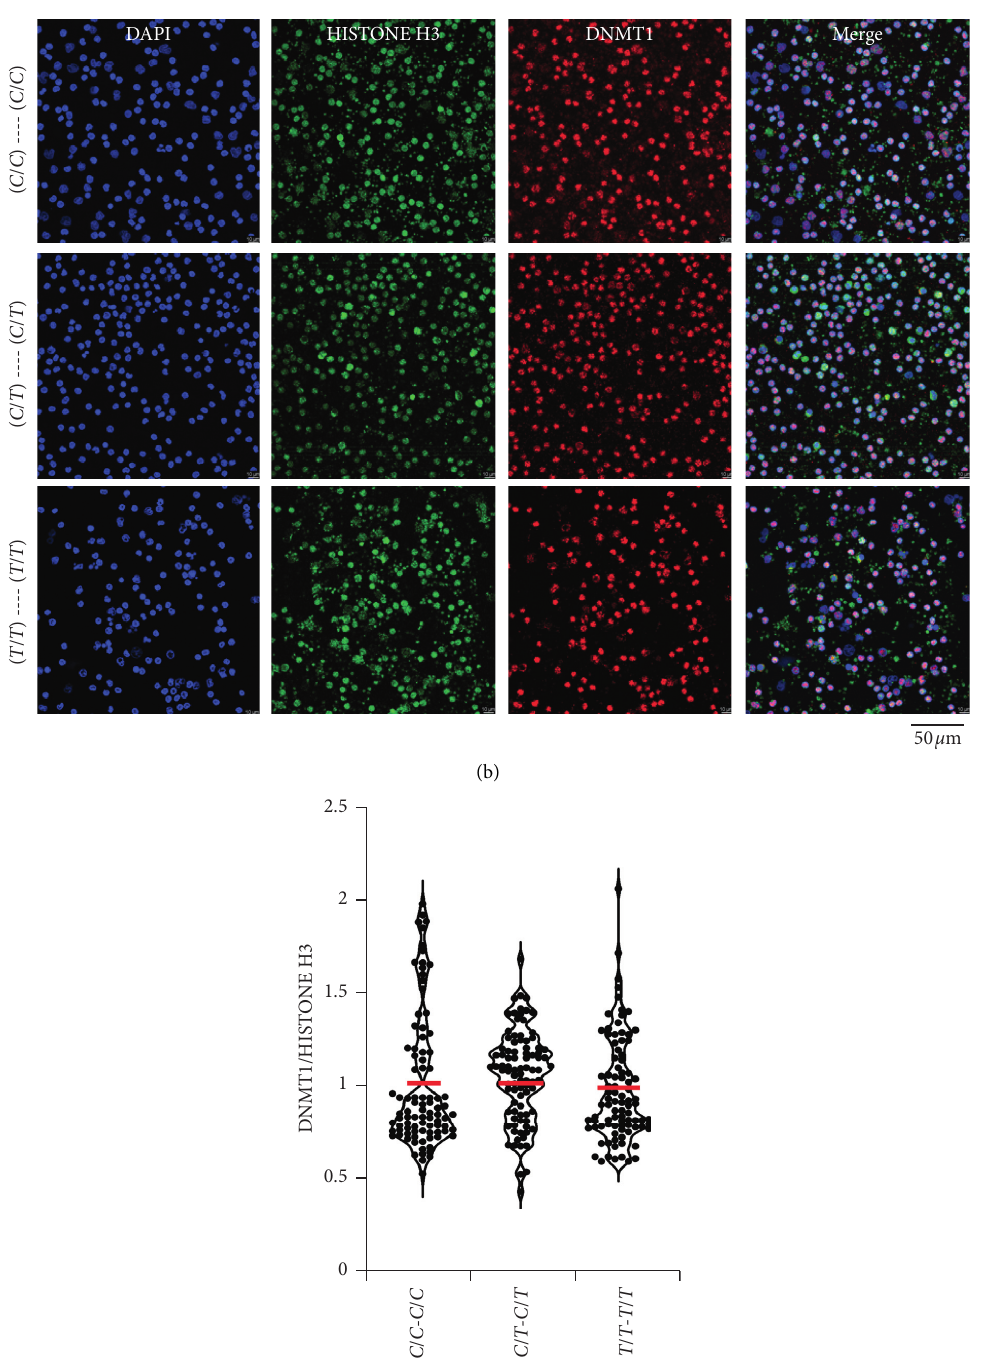
Figure 2: Evaluation of DNMT1 . (a) Violin plots showing relative transcript levels in peripheral blood monocytes of individuals with the haplotypes indicated on the X -axis. (b) Immunofluorescence of peripheral blood monocytes with antibodies to HISTONE H3 (green) and DNMT1 proteins (red). (c) Quantification of the signals obtained for DNMT1 after normalization for the signals obtained with HISTONE H3 in peripheral blood monocytes of three individuals each for the genotypes